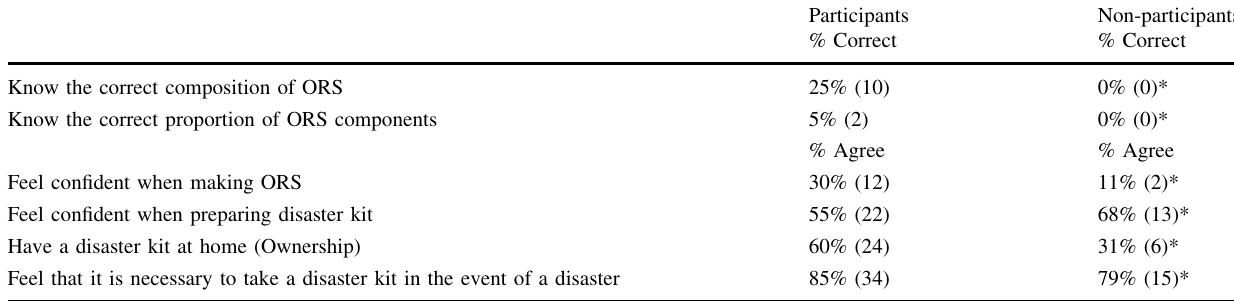
Table 4 Knowledge and attitude change 12 months post-intervention (2015), comparing the 2014 health intervention participants and non- participants ( n = 59)